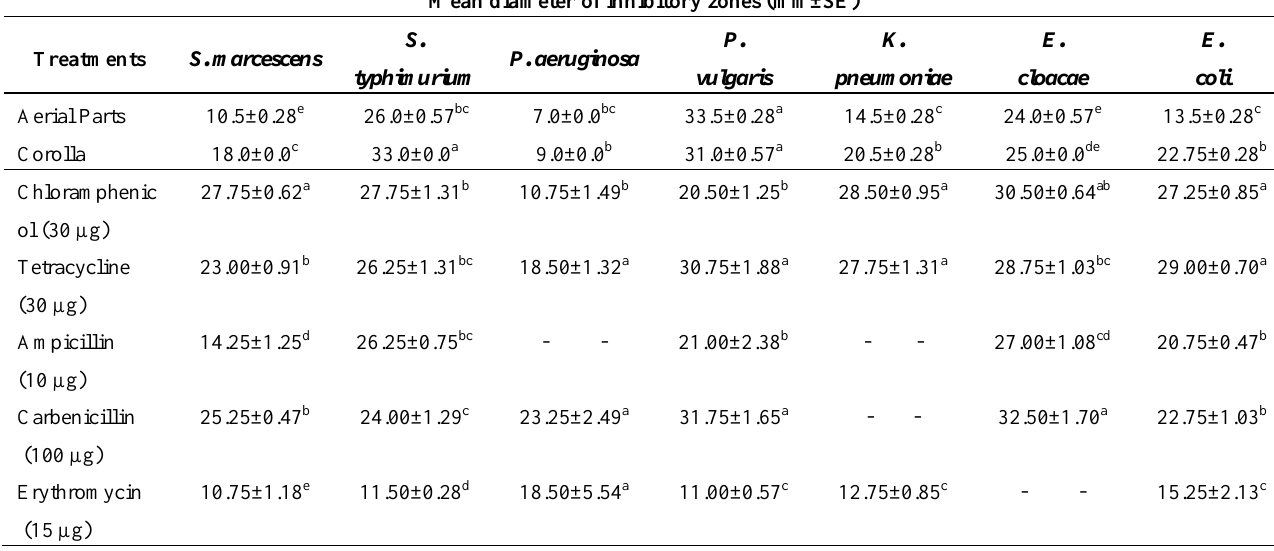
Table 3. Antibacterial activity against Gram-negative bacteria of the aerial parts and corolla essential oils from O.